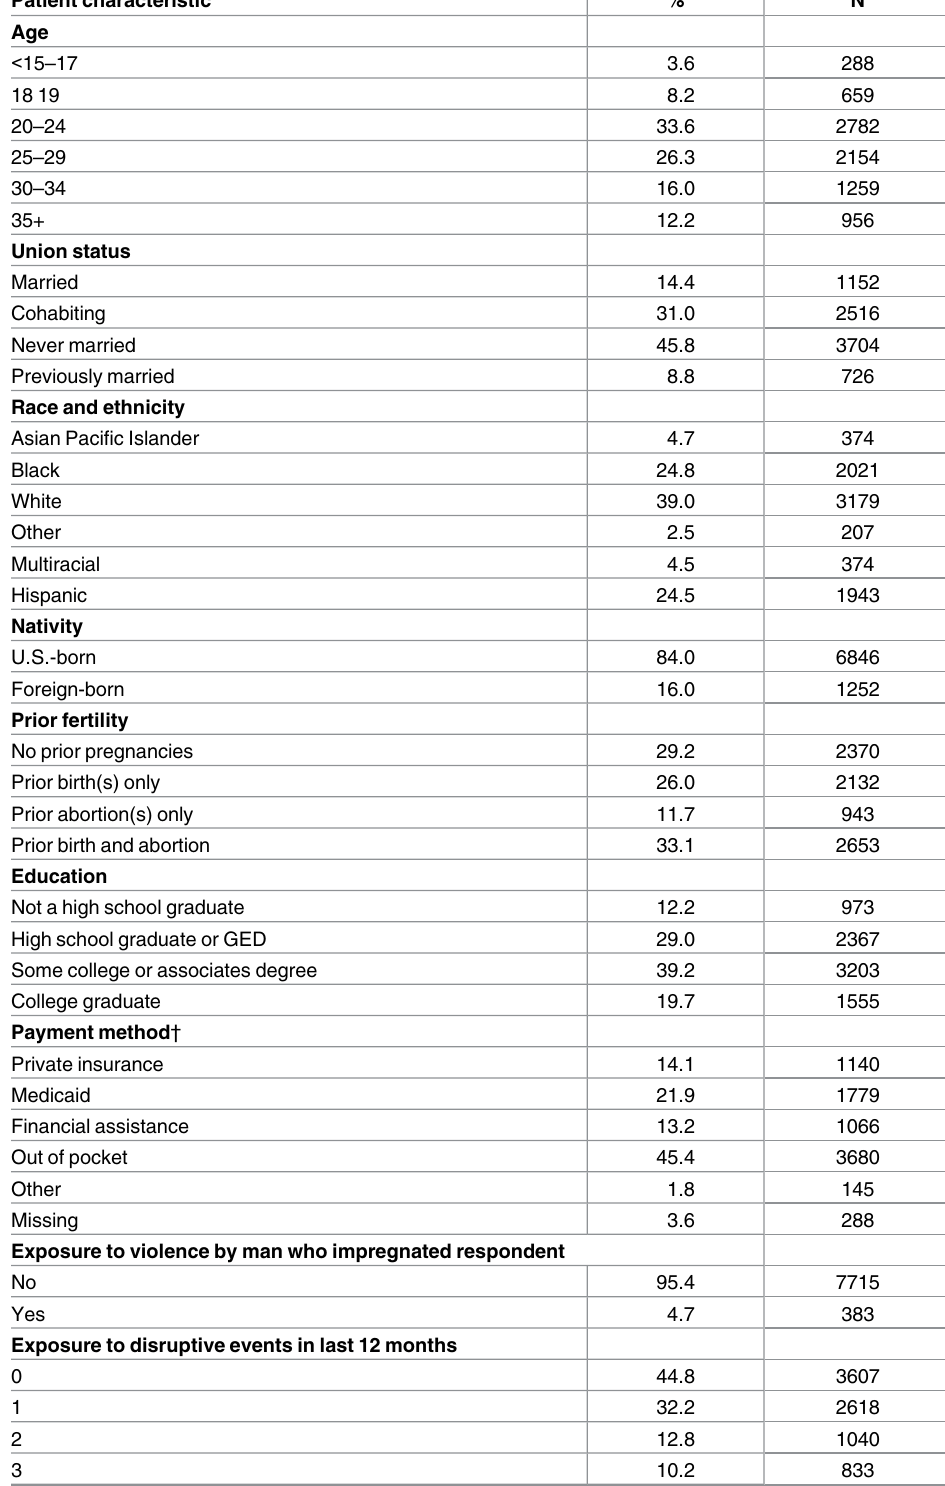
Table 1. Characteristics of non-hospital U.S. abortions patients,